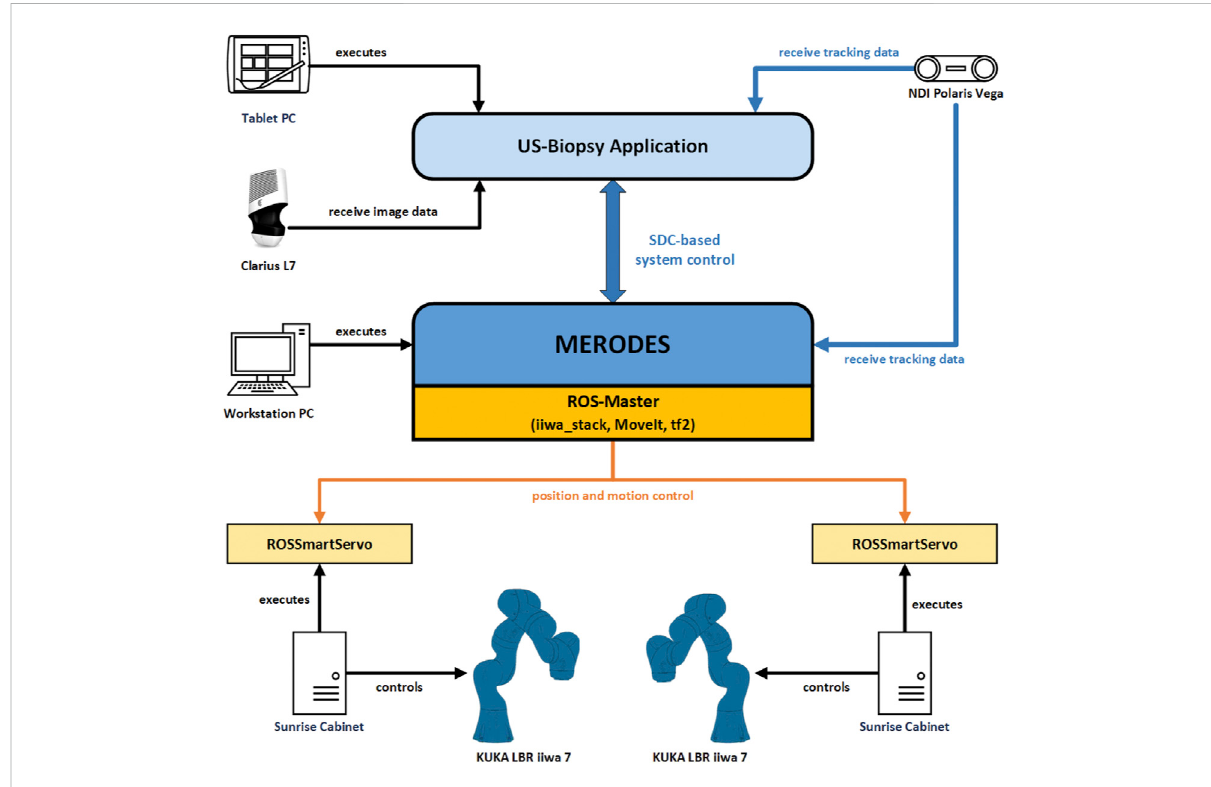
FIGURE 4 The communication and information exchange between the components of the dual-arm setup. Blue arrows represent SDC-based communication; orange arrows represent ROS-based